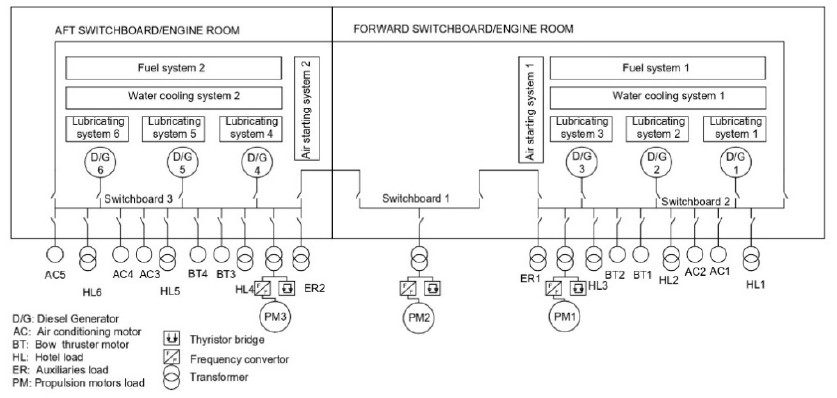
Figure 1. Description of the reference cruise ship DEP plant architecture.